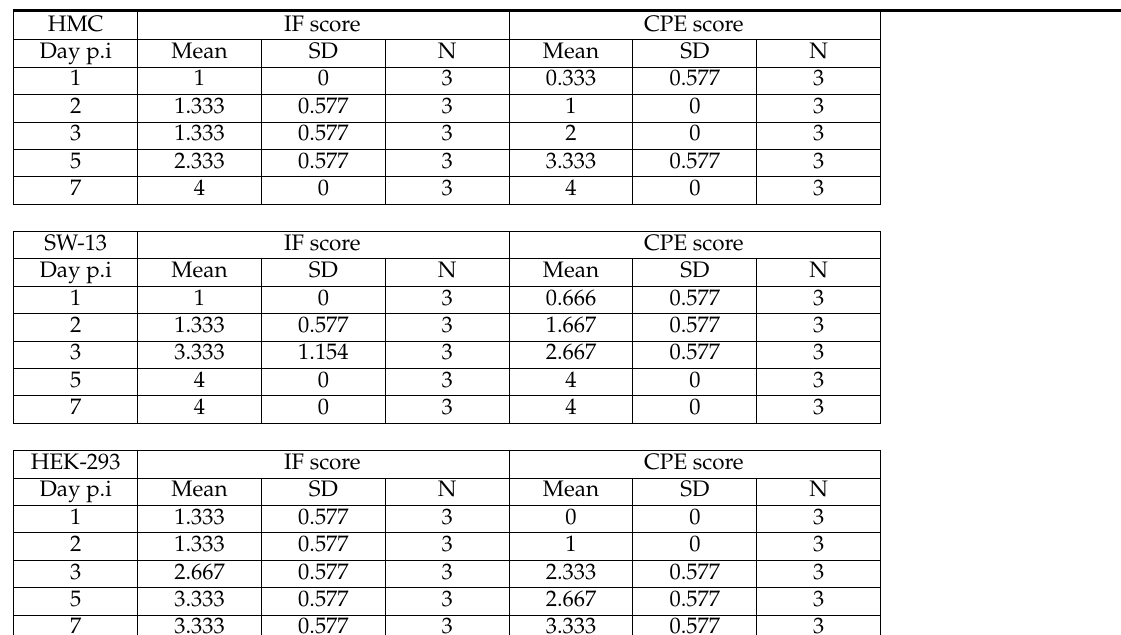
Table A1. Raw statistics of IF, CPE, and MOI